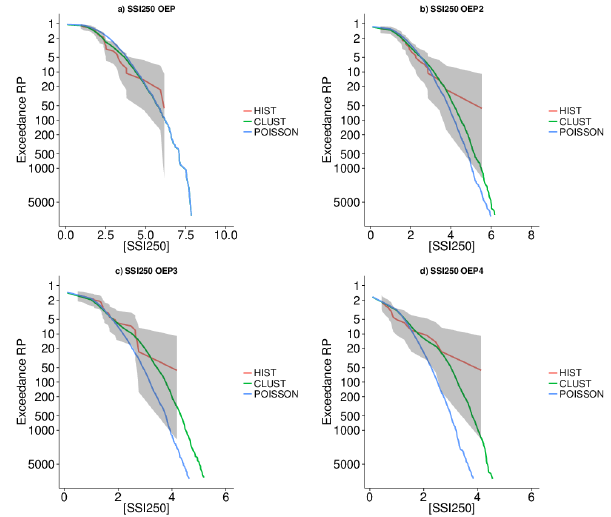
Figure 2. The upper left panel depicts a set of occurrence ex- ceedance probability (OEP) curves. On the vertical axis we have the return period (1 divided by the exceedance probability). On the hor- izontal axis is the SSI250 intensity measure. The red line represents the OEP derived from the 135 representative European windstorm events (historical data). The blue line depicts a model of the data using a Poisson frequency assumption. The green line represents a clustered model for the data using a Poisson mixture methodology. The shaded grey bounds represent the 5/95 uncertainty bands on the empirical OEP curve. The upper right panel depicts the OEP2 derived from the distribution of the second maximum loss (same plotting convention as for the upper left). The lower left and lower right panels depict analogous results for the third and fourth event occurrence distributions (OEP3 and OEP4